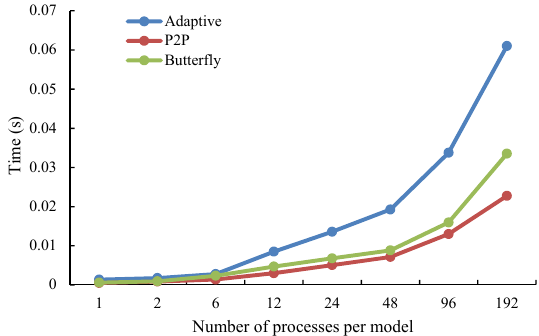
Figure 14. Initialization time ( y axis) of one data transfer between two toy models using a rectangular grid (of 192 × 96 grid points) when varying the number of processes per model ( x axis). There are 10 2-D coupling fields transferred from the source toy model to the target toy model. In each test, all processes of the sender in the P2P implementation have the same number of MPI messages. If the number of processes per model is less than 24, the number of MPI messages per sender process in the P2P implementation is equal to the number of processes per model; otherwise, the number of MPI messages per sender process in the P2P implementation is 24. The parallel decompositions of the sender and the receiver for a given average number of MPI messages are generated by Algorithm 1.